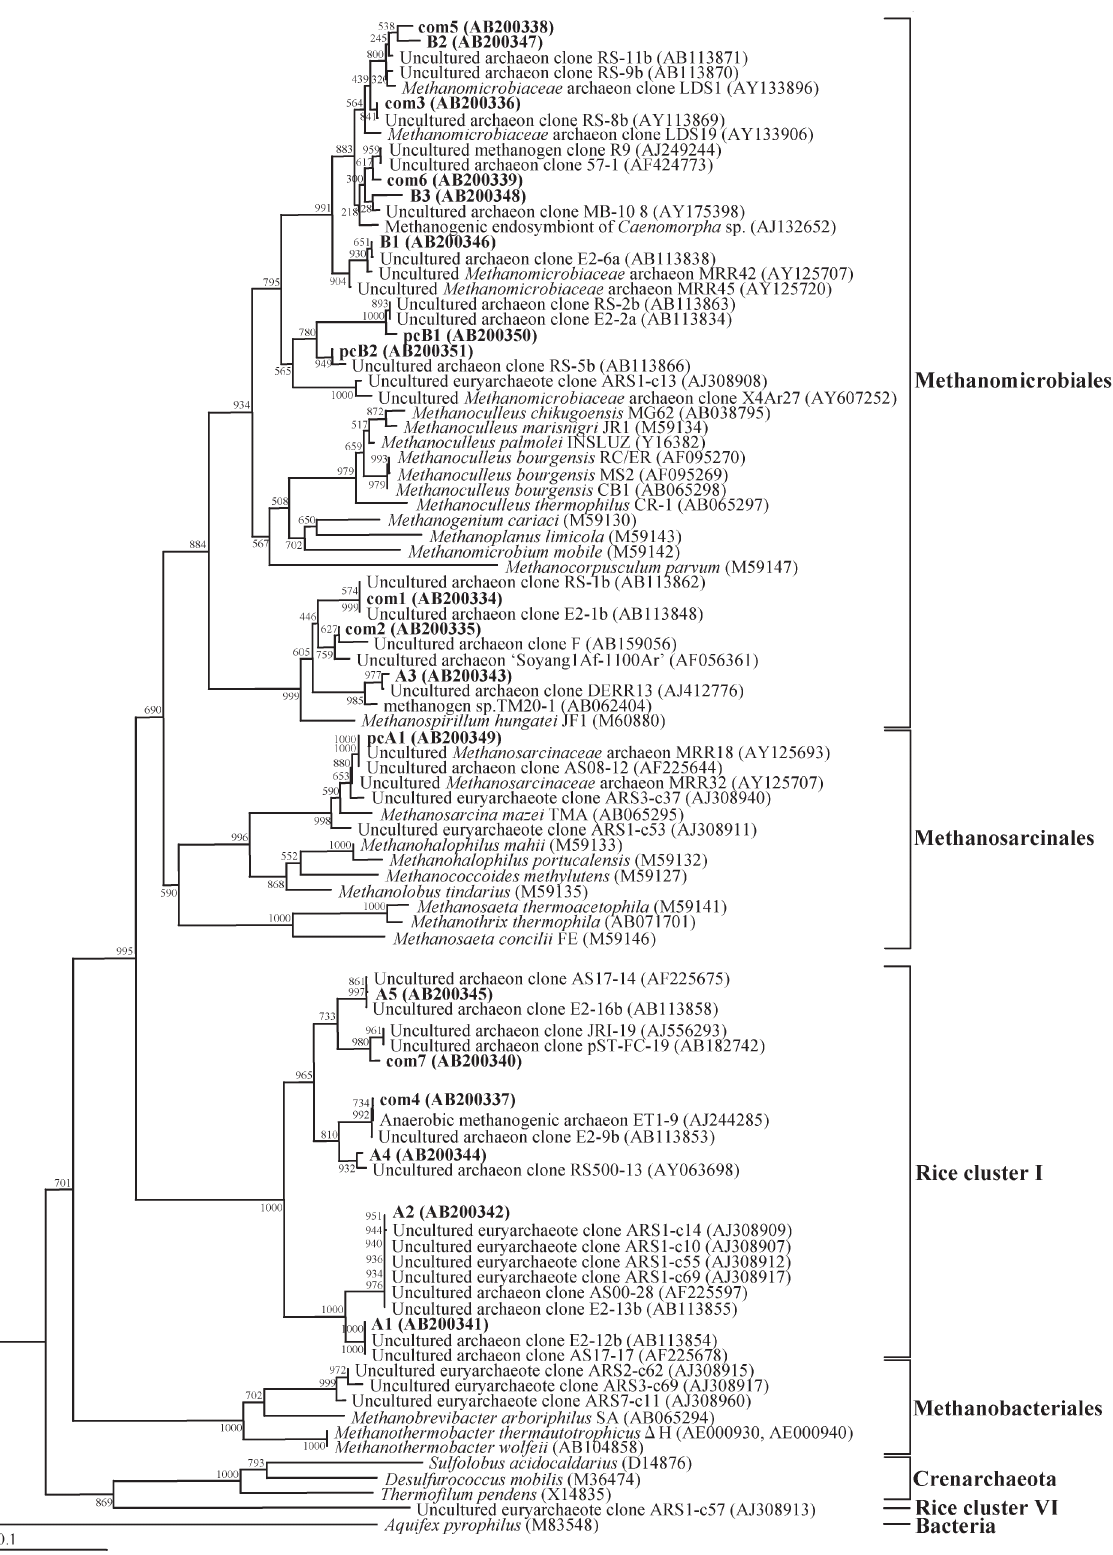
Figure 4. Phylogenetic relationships of methanogenic archaeal 16S rDNA sequences of characterized DGGE bands. The sequences obtained in the present study are shown in bold. Bootstrap values greater than 500 (out of 1000 replicates) are shown at branch points. Aquifex pyrophilus was used as an outgroup. The scale bar represents 0.1 substitutions per nucleotide. Accession numbers of sequences are indicated in